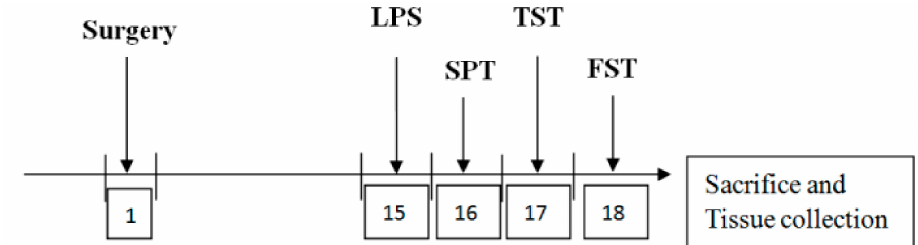
Figure 1. Timeline of the experimental procedures. SPT: sucrose preference test; TST: tail suspension test; FST: forced swimming test; LPS: